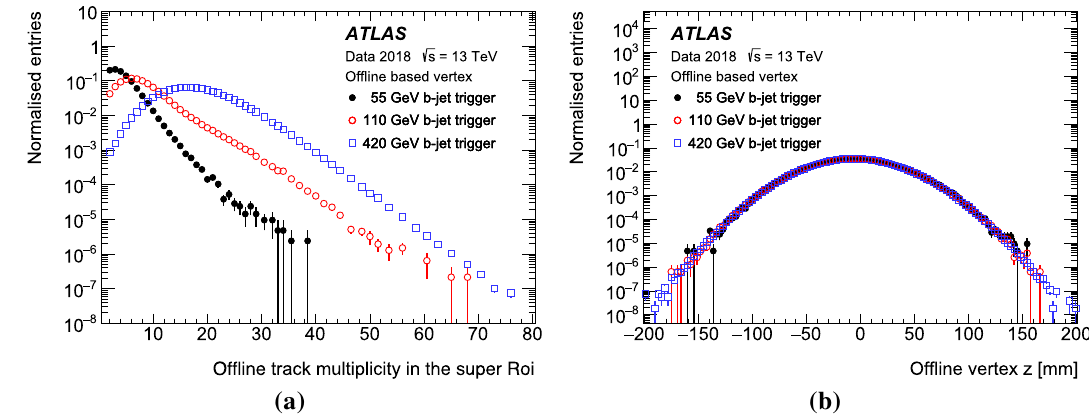
Fig. 40 The distribution of the offline track multiplicity for all selected offline tracks within the super RoI used for the vertex tracking ( a ), and their distribution in track z 0 position at the beam line ( b